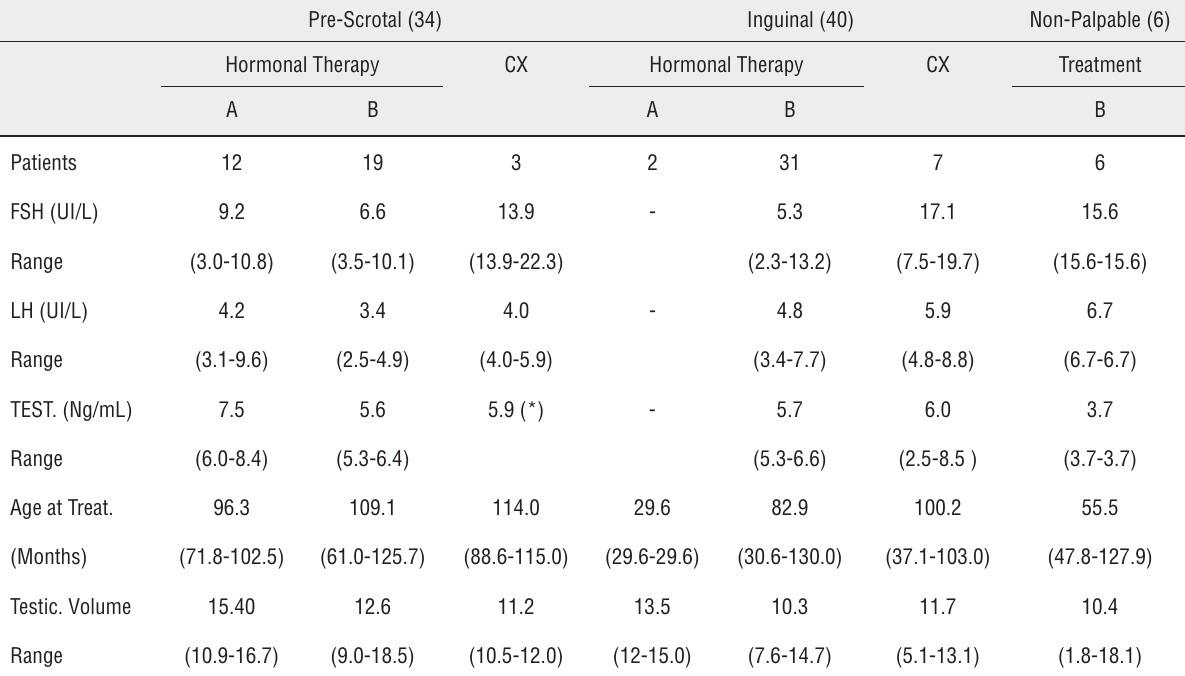
Table 3 - Bilateral cryptorchidism (n=80) Features based on testis location and therapy used (A-only hormonal treatment; B-hormonal first and surgery later; CX – surgery